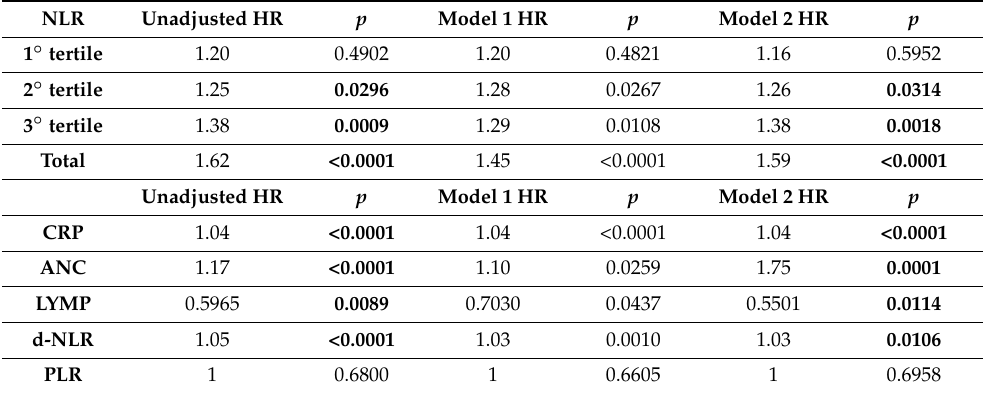
Table 3. Cox regression models predicting mortality. Model 1: adjusted for sex and age. Model 2: adjusted for